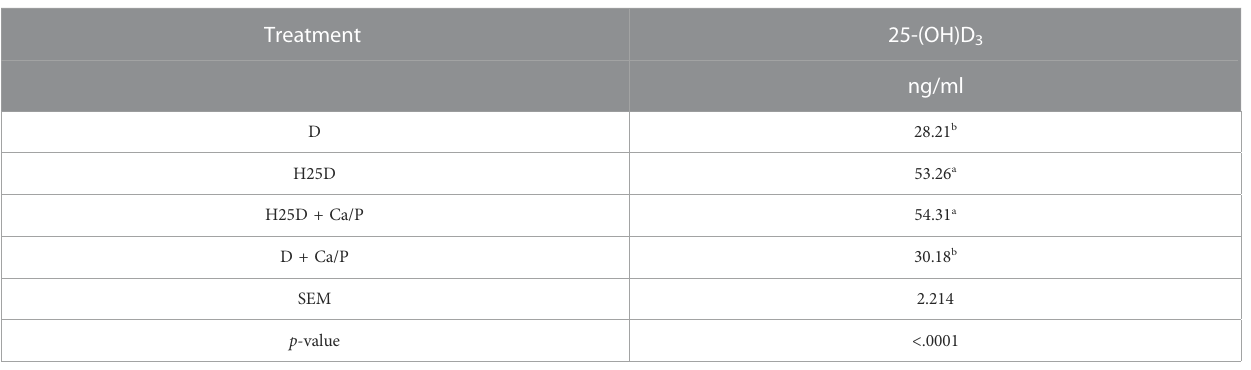
TABLE 9 25-(OH)D 3 level in the